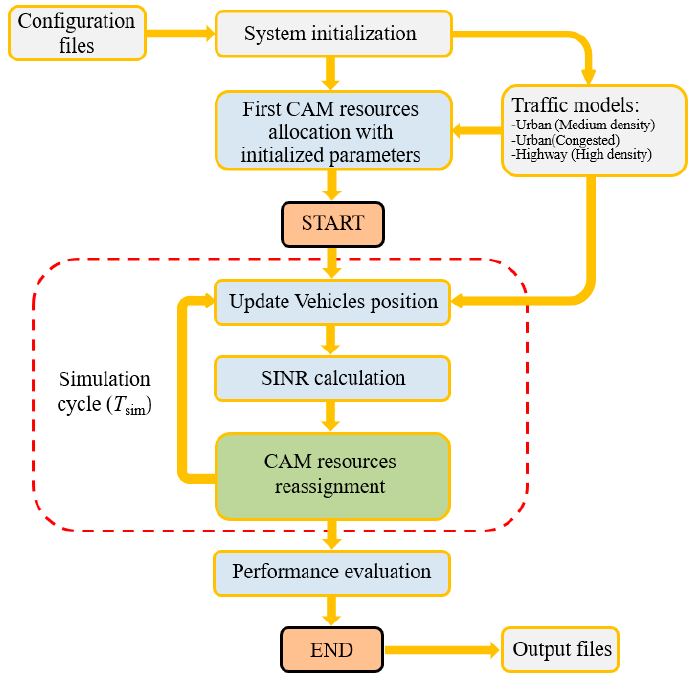
Figure 5. LTEV2Vsim simulator.